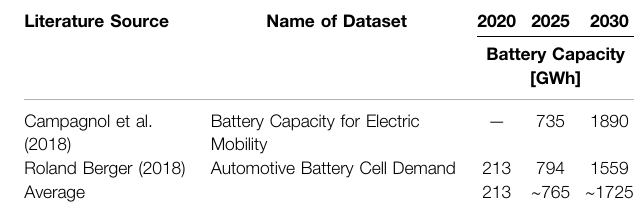
Table 6 | Literature - Li-Ion battery demand in